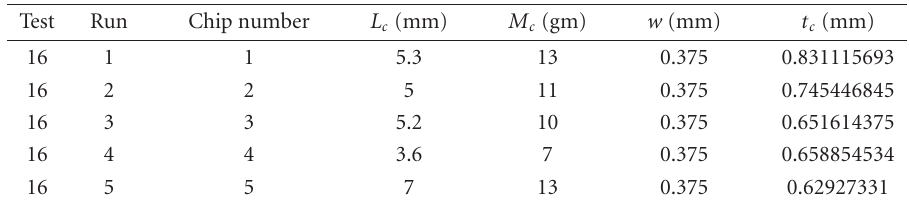
Table 5 . 2 . Example of calculations made for deducing average chip thickness of test 16 (run